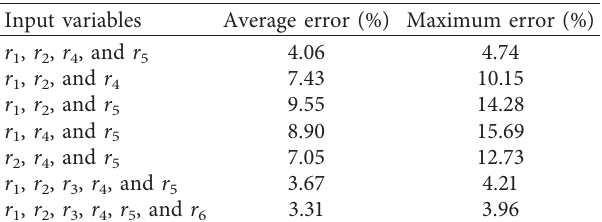
Table 8: Calculation results with different numbers of input